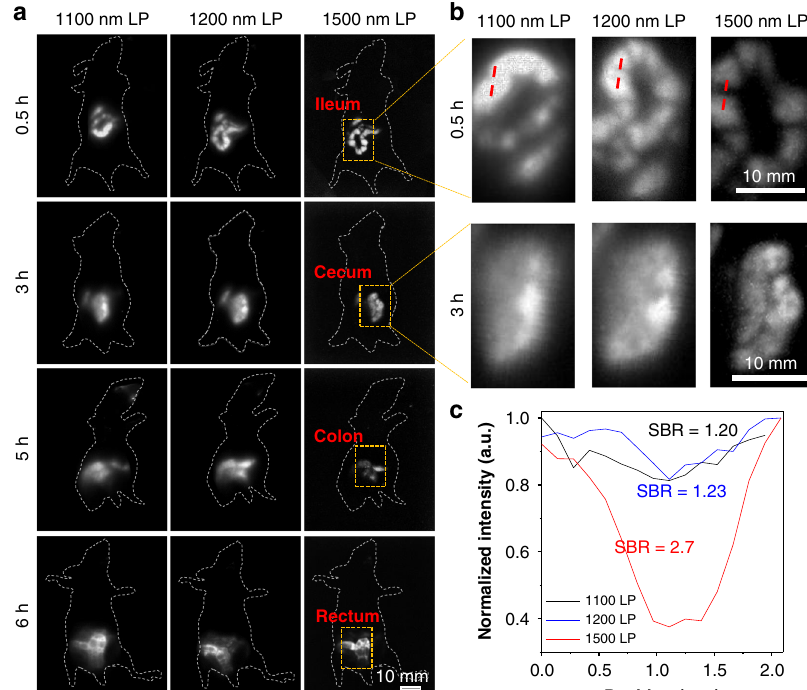
Fig. 7 NIR-II fl uorescence images of the intestinal tract. a Real-time monitoring of intestinal peristalsis in living mice gavaged with the 2TT- o C26B NPs (300 μ L, 1 mg/mL) using different LP fi lters (1100 nm LP, 8 ms, 37 mW/cm 2 ; 1200 nm LP, 10 ms, 37 mW/cm 2 ; 1500 nm LP, 75 ms, 110 mW/cm 2 ) at various time points (0.5, 3, 5, 6 h). b Zoom-in images of the two yellow rectangle areas marked in ( a ) (0.5 and 3 h). Yellow-line dashed rectangles in the images at 5 and 6 h in ( a ) are zoomed-in and shown in Supplementary Fig. 24. c A cross-sectional fl uorescence intensity pro fi le along the red-dashed bar at the top of ( b